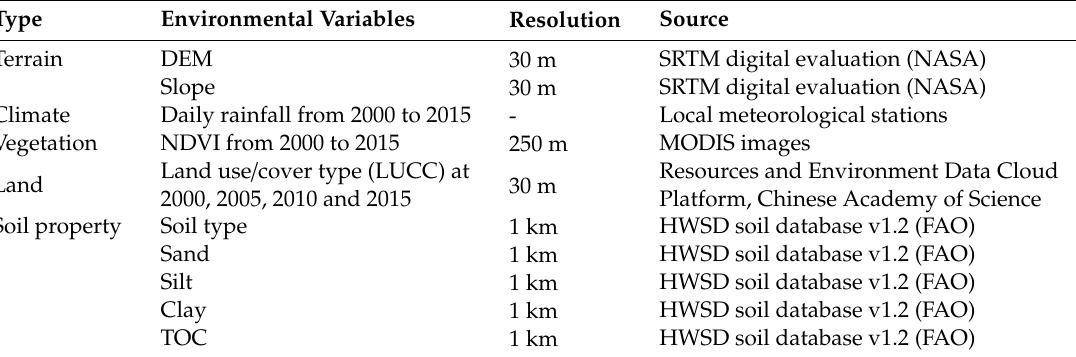
Table 1. List of the datasets used in the RUSLE model and their